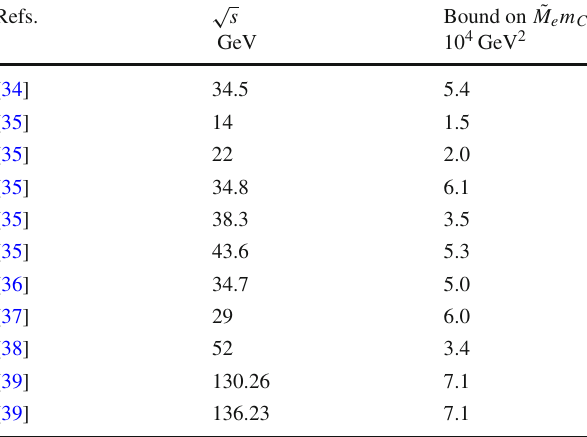
Table 1 Lower bounds on ˜ M e m C